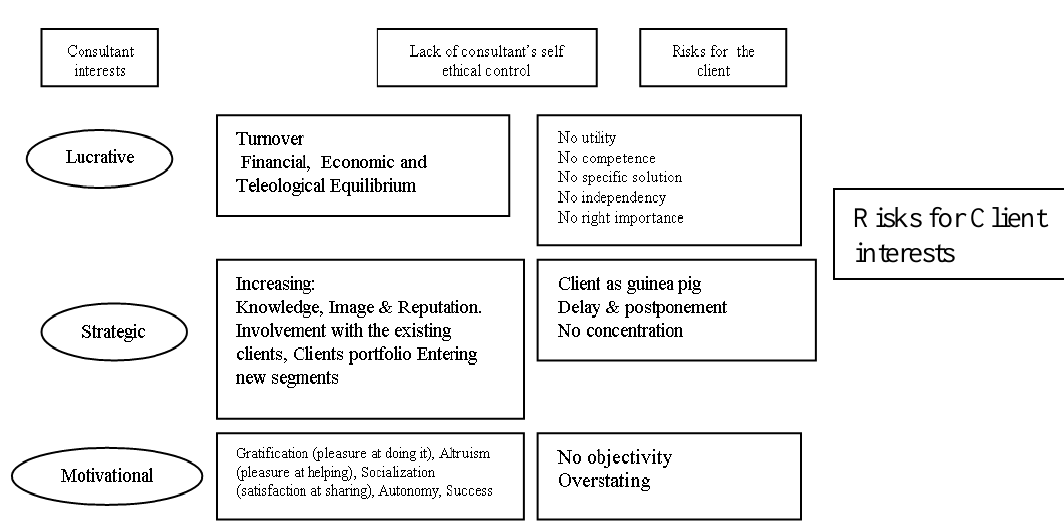
b) Consulting ethical